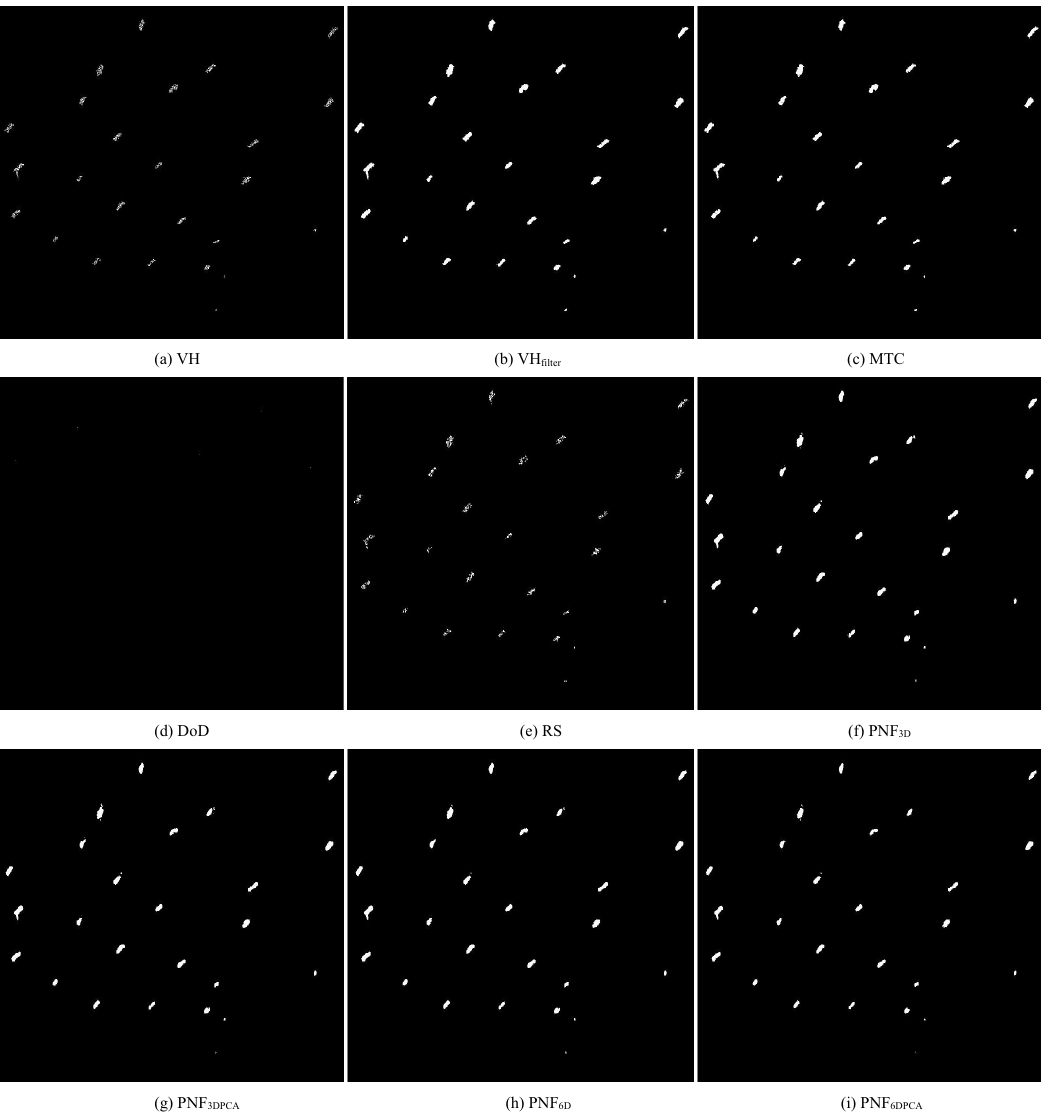
Figure 3. Ship detection results of different methods on A. ( a ) VH; ( b ) VH filter ; ( c ) MTC; ( d ) DoD; ( e ) RS;